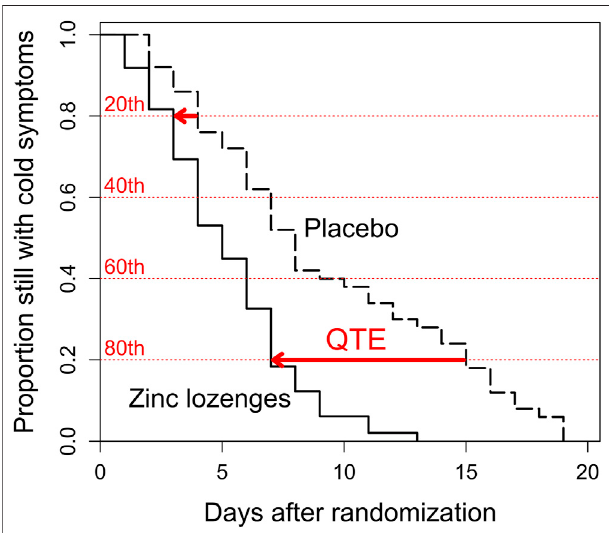
FIGURE 1 | Recovery from the common cold and illustration of the quantiletreatmenteffect(QTE)intheMossadetal.(1996)trial.Thesizesofthe steps downwards indicate the number of patients who recovered on a particular day. The red horizontal dotted lines indicate the 20th, 40th, 60th, and 80th percentiles of the distribution of common cold duration, starting with the shortest colds from the top downwards, compare with Figure 2A . The horizontal red arrows indicate the QTE effects at the 20th and 80th